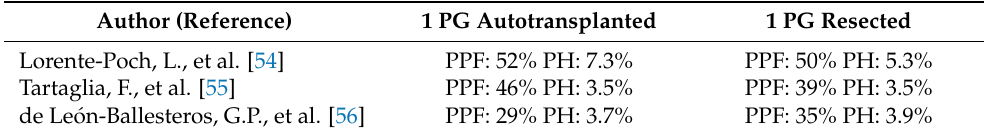
Table 2. Rates of postoperative parathyroid failure (PPF) and permanent hypoparathyroidism (PH) after total thyroidectomy when three parathyroid glands were preserved in situ, whereas the fourth one was either autotransplanted or inadvertently